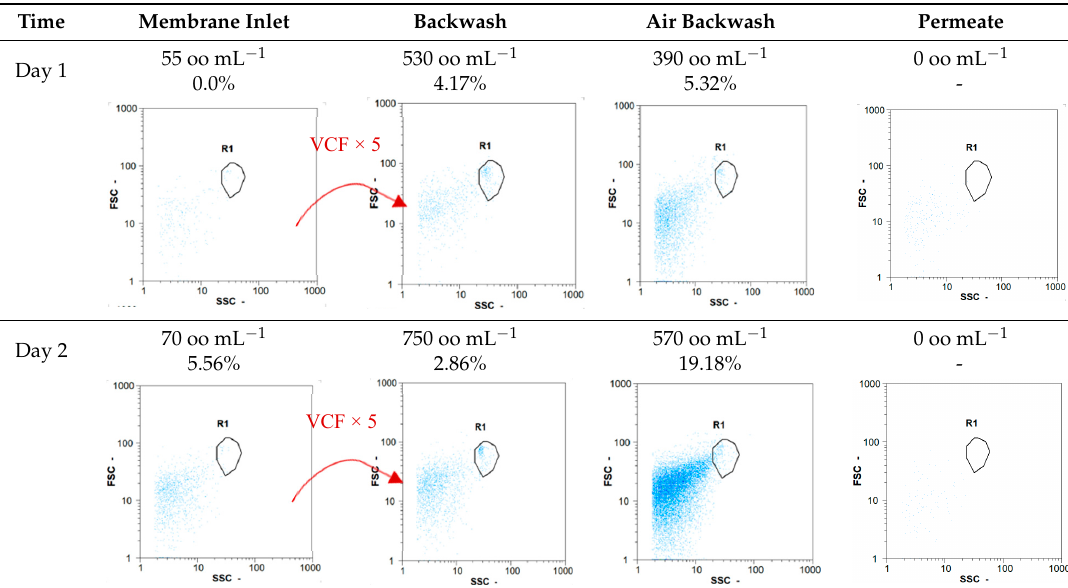
Table 7. Flow cytometry of oocytes—(J = 60 L h − 1 m − 2 and t filtration = 60 min; chronic pollution).